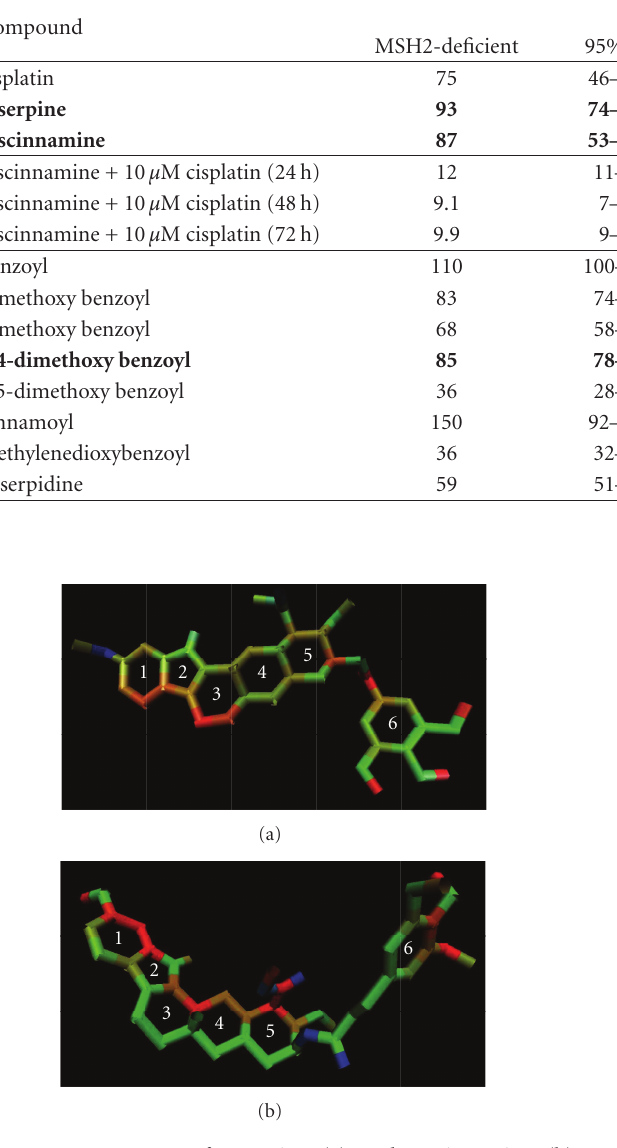
Figure 3: Structures of reserpine (a) and rescinnamine (b) analyzed by computational modeling depicting favorable (red) and unfavorable (blue) interactions with amino acids within MutS-binding pocket. Green indicates interactions of intermediate binding